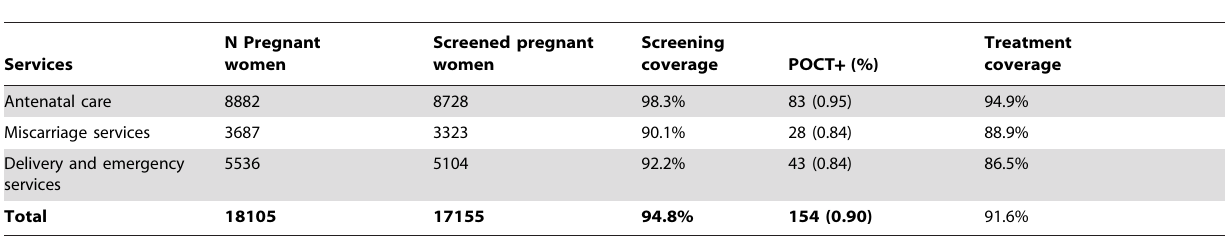
Table 1. Screening and treatment coverage with POCT for syphilis at INMP and in Ventanilla-Callao (Jan-Nov 2010).